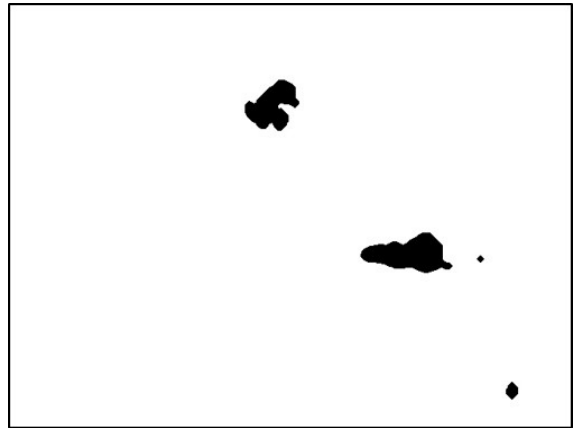
Figure 20. Result of filling the image with flood fill.